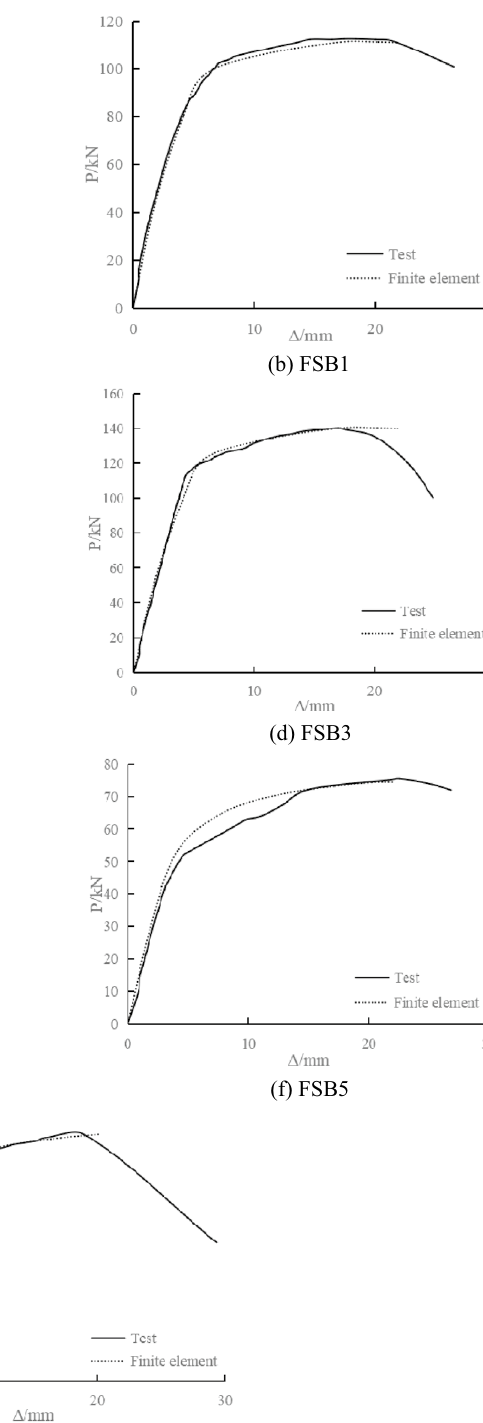
Figure 17. Comparison between test and finite element calculation of load–deflection